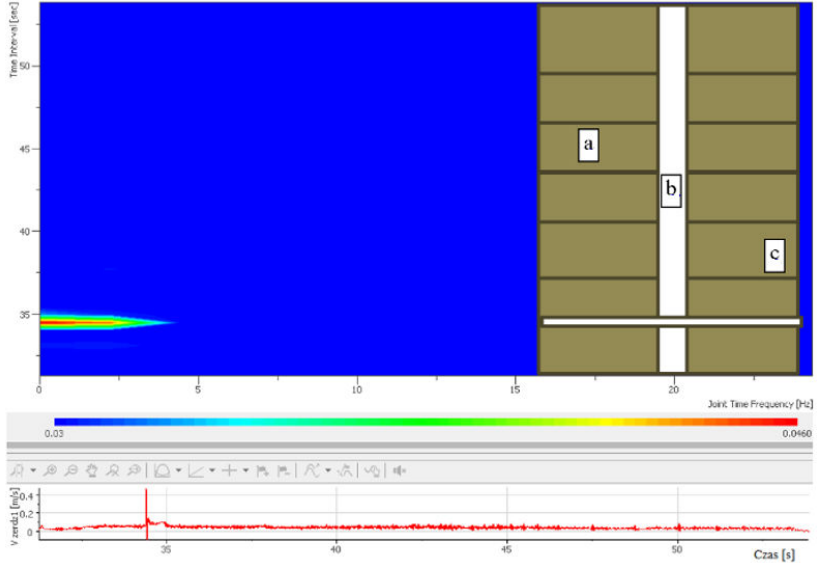
Figure 21. The detected signal on the recorded spectrogram corresponding to the location the critical discontinuity for borehole 6, rod 1—Hanning window, time domain sieve line set to 50, amplitude level display > 0.03; a, rock layer; b, borehole; c,